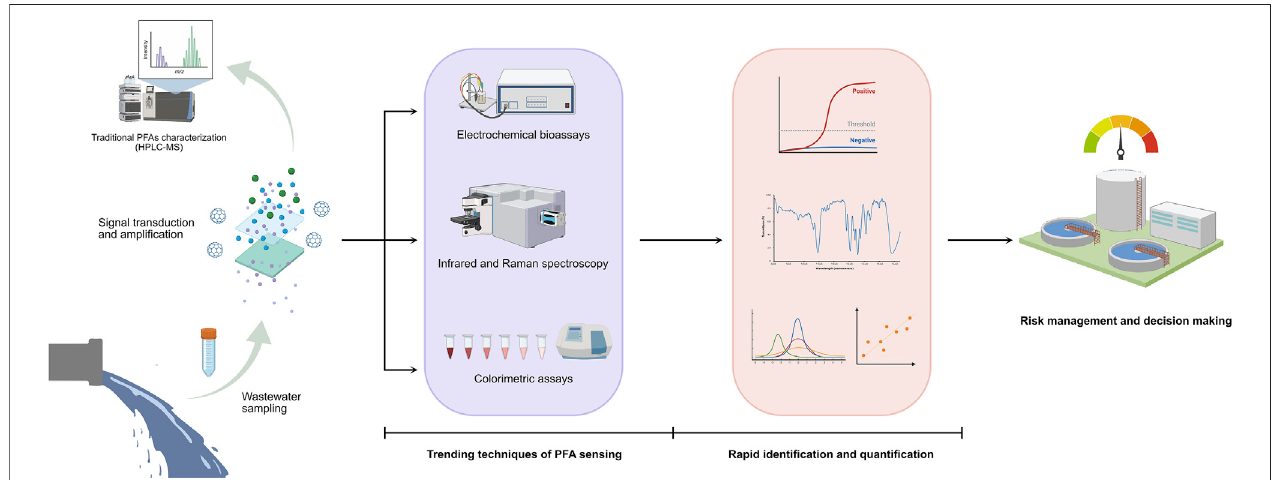
FIGURE 5 | Trends in PFA detection for wastewater treatment systems. Created with